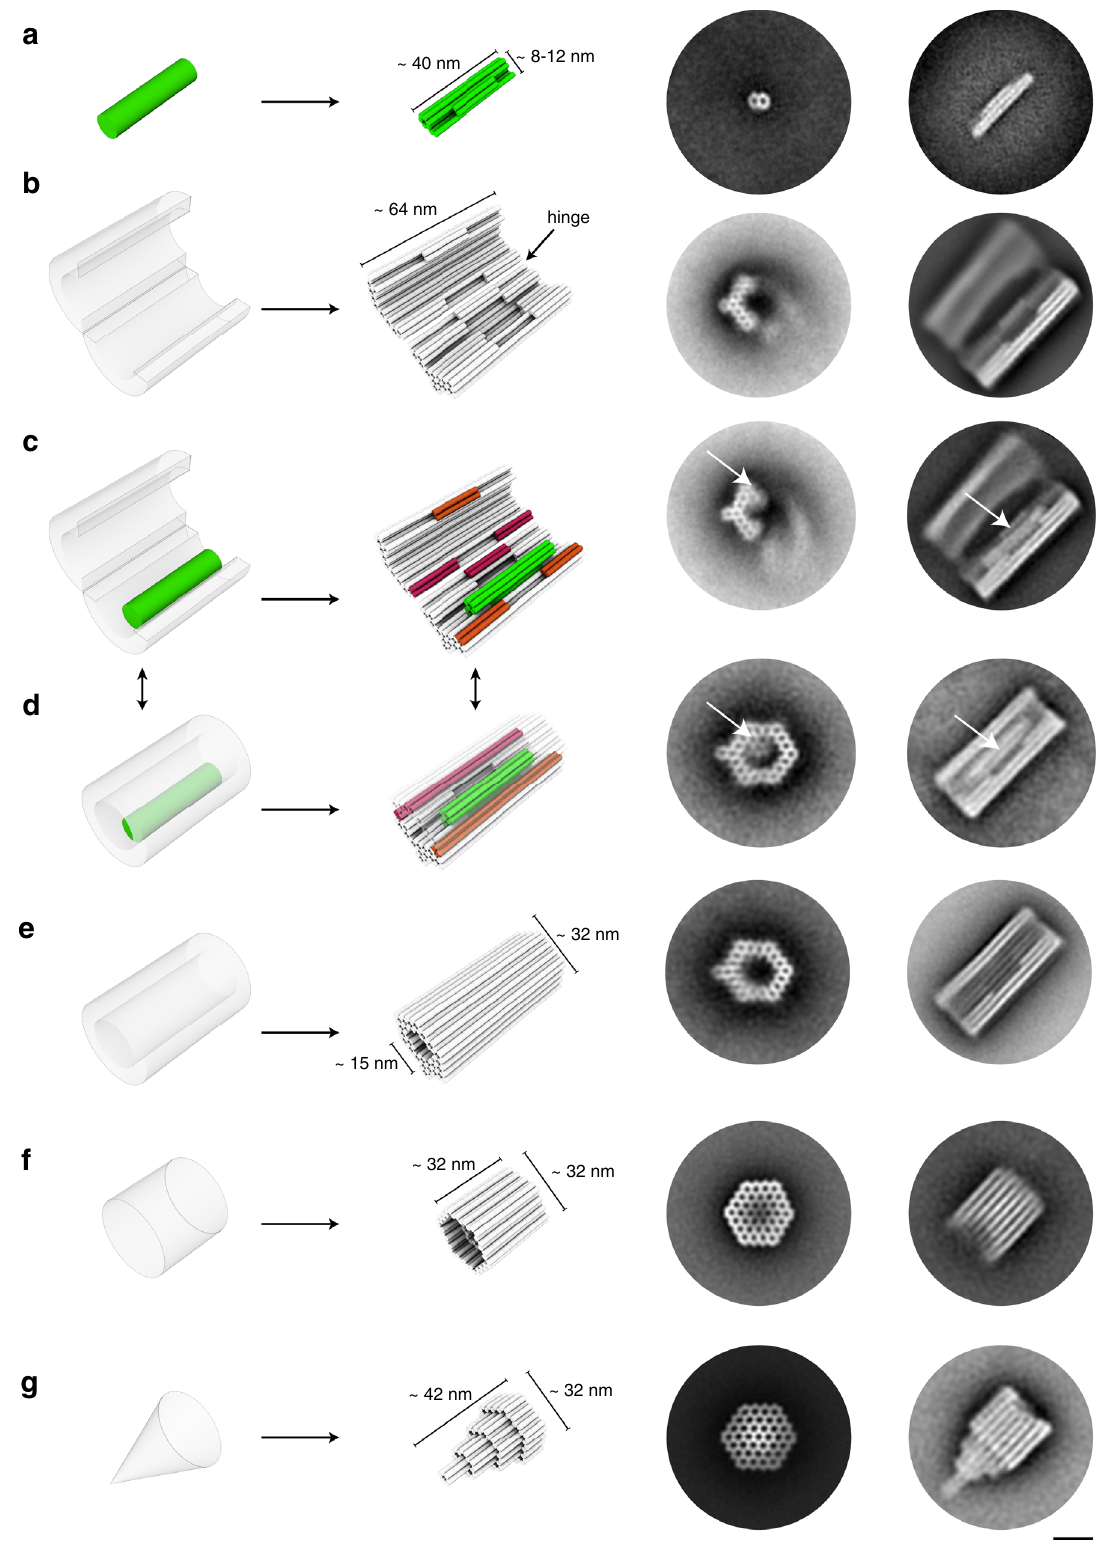
Fig. 2 Construction of components with DNA origami. a – g Left: Schematics of how target components are approximated as cylinder models. Cylinders represent DNA double-helices. Right: Representative 2D class average images from negative-staining TEM micrographs, with viewing angle along the helical axis and perpendicular to the helical axis, respectively. Scale bar for all class averages: 20 nm. c , d Orange, magenta: protrusions and recesses involved in closing the barrel. Source data are provided as a Source Data fi